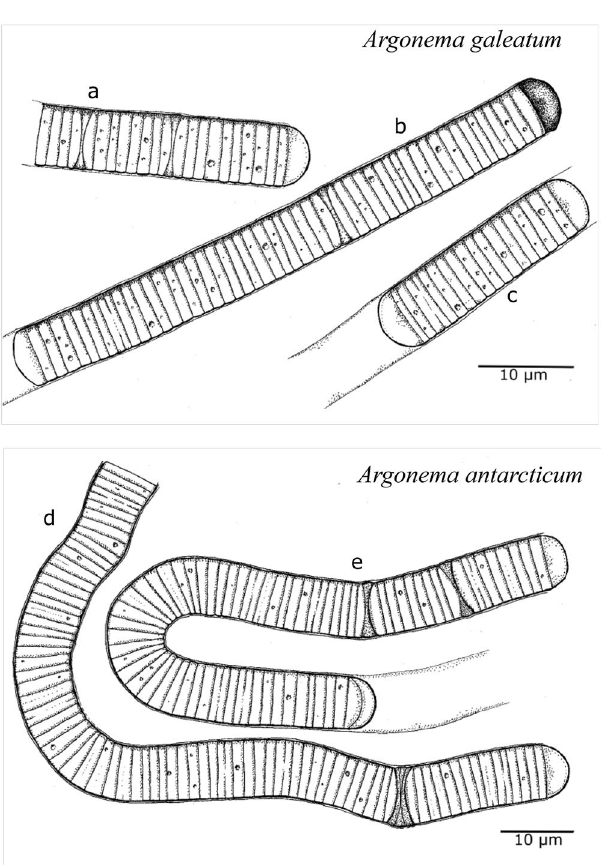
Figure 11. Lineworks of Argonema galeatum ( a – c ) and Argonema antarcticum ( d , e ). ( b ) – filament of A. galeatum with typical dark apical cell. ( c – A. galeatum hormogonium. ( e ) – filament of A. antarcticum with necridic cells and protruding